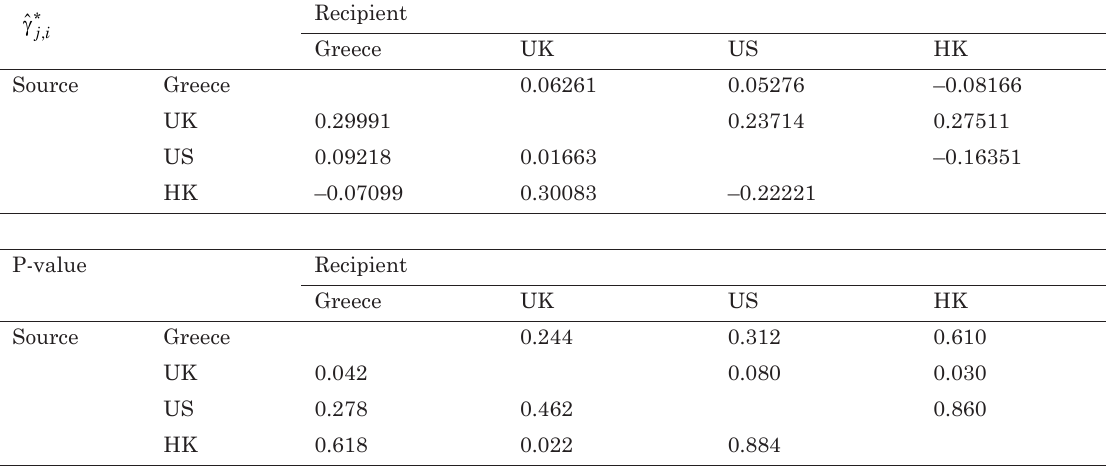
Table 7. The result of the case-resampling bootstrap method on the real estate